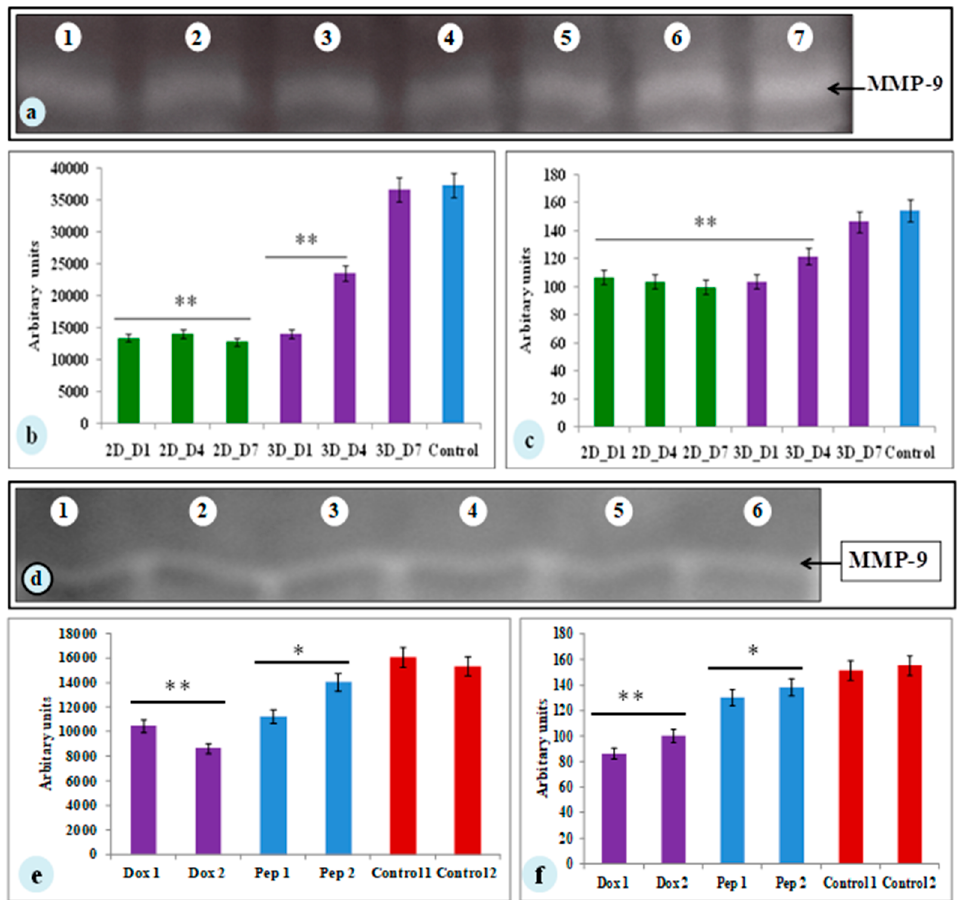
Figure 4. Glucose metabolic studies of MDA ‐ MB ‐ 231 cells cultured on 2D and 3D silk constructs; a ) glucose concentration (mg/mL) and b ) LDH activity (U/mL) in the spent media of cells grown on 2D and 3D constructs. The data is denoted as mean ± SD (n = 3, P < 0.01, P < 0.05). * P < 0.05; ** P < 0.01.